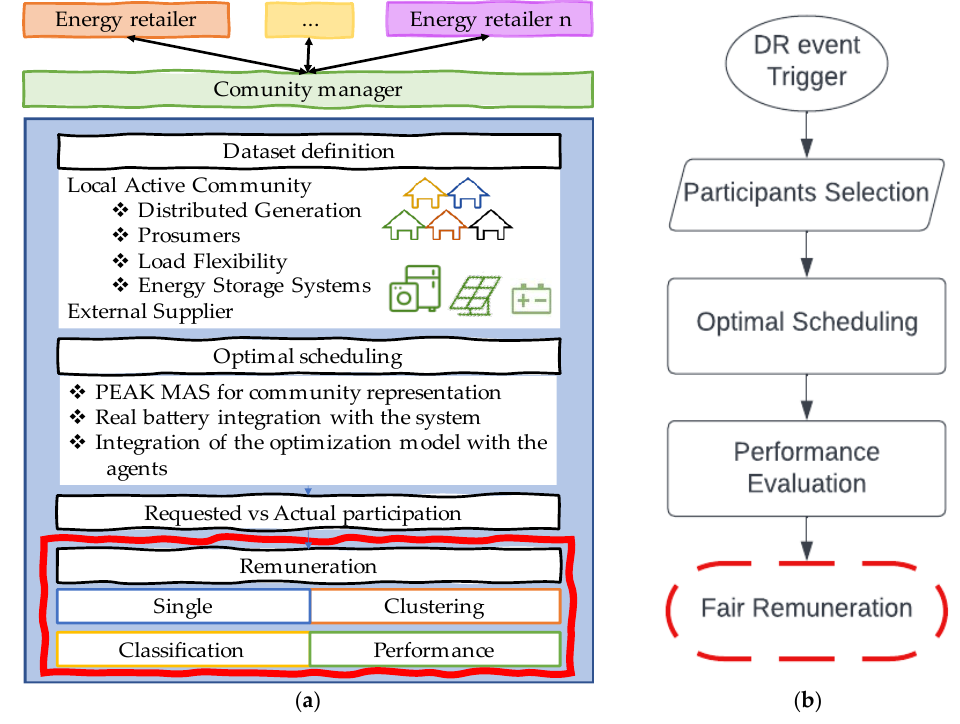
Figure 1. Proposed methodology: ( a ) diagram, ( b ) flowchart.